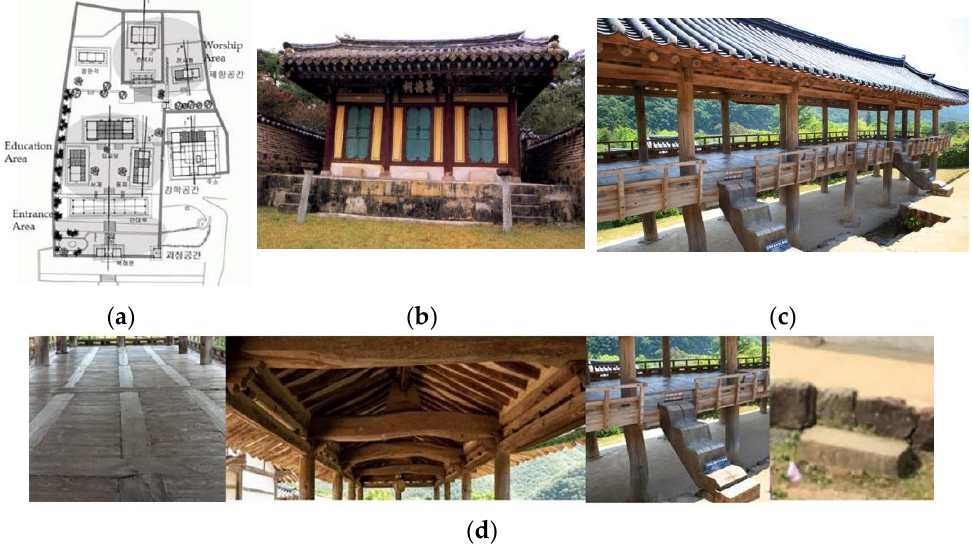
Figure 9. ( a ) Axis Map of Pingshan Academy (source: Lee Sang-hae); ( b ) Chung Tak Hall, Pingshan Academy (source: Lee Sang-hae); ( c ) Pingshan Academy (source: Lee Sang-hae); ( d ) simple element of Pingshan Academy (source: Lee Sang-hae.